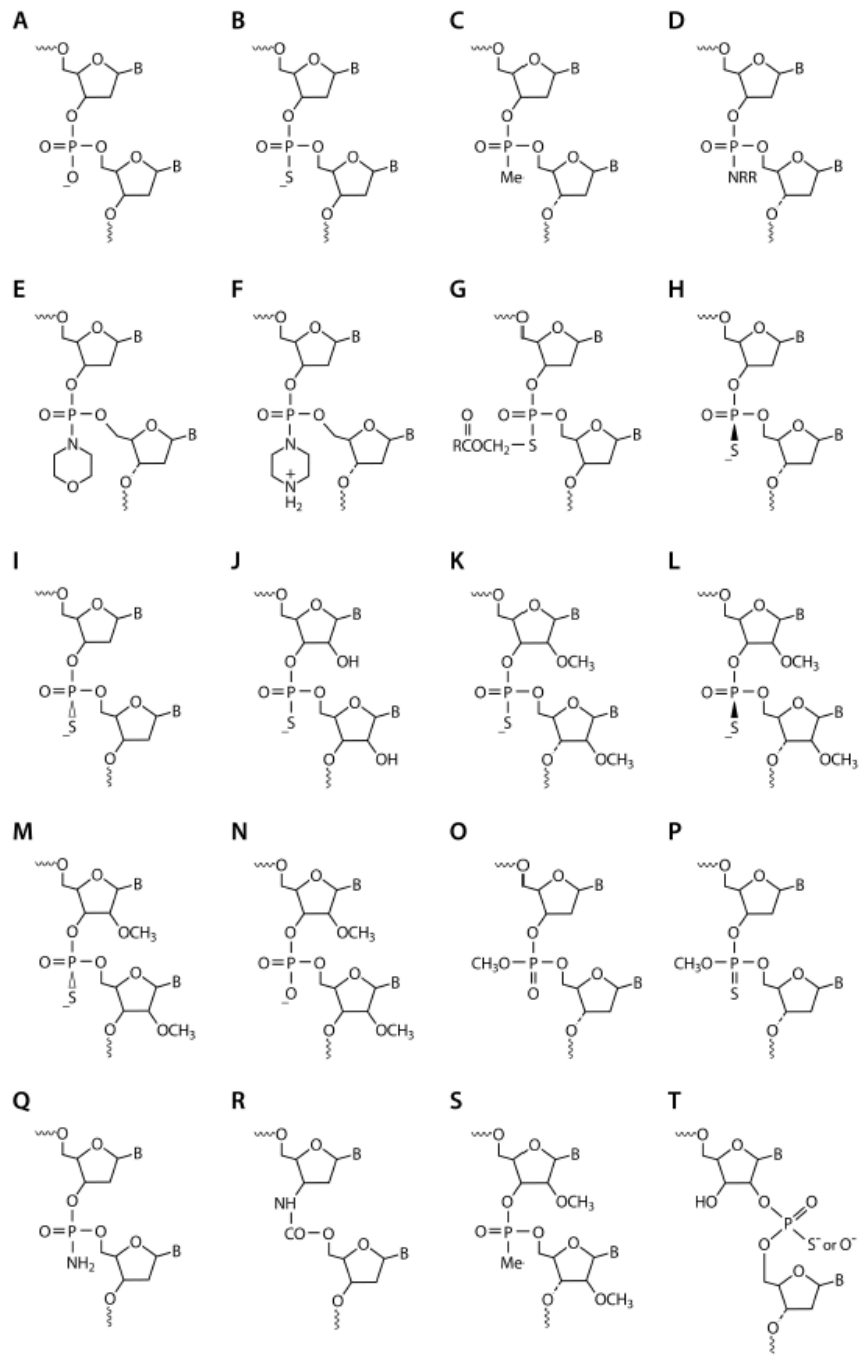
Figure 1. Chemical structures: ( A ) phosphodiester oligonucleotide (PO-ODN), ( B ) phosphorothioate ODN (PS-ODN), ( C ) methylphosphonate ODN (PME-ODN), ( D ) phosphorodiamidate, ( E ) phosphomorpholidate , ( F ) phosphopiperazidate (PN-ODN), ( G ) acyloxyester PS-ODN, ( H ) R p-PS-ODN, ( I ) S p-PS-ODN, ( J ) PS-oligoribonucleotide (PS-ORN), ( K ) 2 (cid:48) -O-methyl PS-ORN (2 (cid:48) PS-ORN), ( L ) Rp 2 (cid:48) PS-ORN, ( M ) Sp 2 (cid:48) PS-ORN, ( N ), 2 (cid:48) PO-ORN, ( O ) methylphosphotriester, ( P ) methylphospho- thiotriester, ( Q ) primary phosphoramidate, ( R ) carbamate, ( S ) 2 (cid:48) -O-methylphosphonate, and ( T